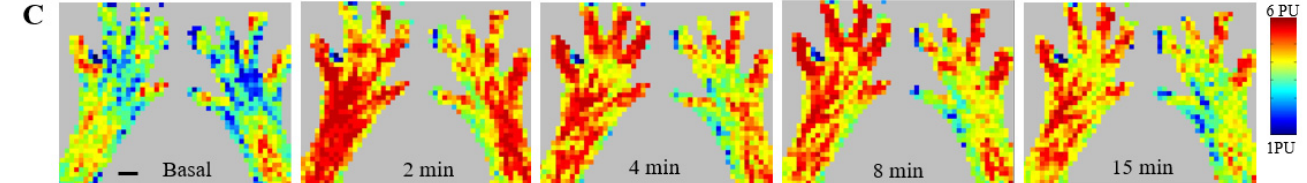
Figure 2. ( A ) Time course of mustard oil–induced increases in perfusion of the medial (dashed line) and lateral (solid line) parts of the dorsal skin of the right hind paws of rats ( n = 5). ( B ) Time course of mustard oil–induced increases in perfusion of the medial (dashed red line) and lateral (solid line) parts of the dorsal skin of the right hind paws of rats 1 week after perineural treatment of the right saphenous nerve ( n = 5). *: significantly different from the perfusion of the lateral part of the dorsum of the hind paw skin. ( C ) A series of perfusion images illustrating the time course of mustard oil–induced increases in blood flow in the dorsum of a rat hind paw. The right saphenous nerve was treated with capsaicin 5 days before the experiment. Scale bar represents 5 mm.